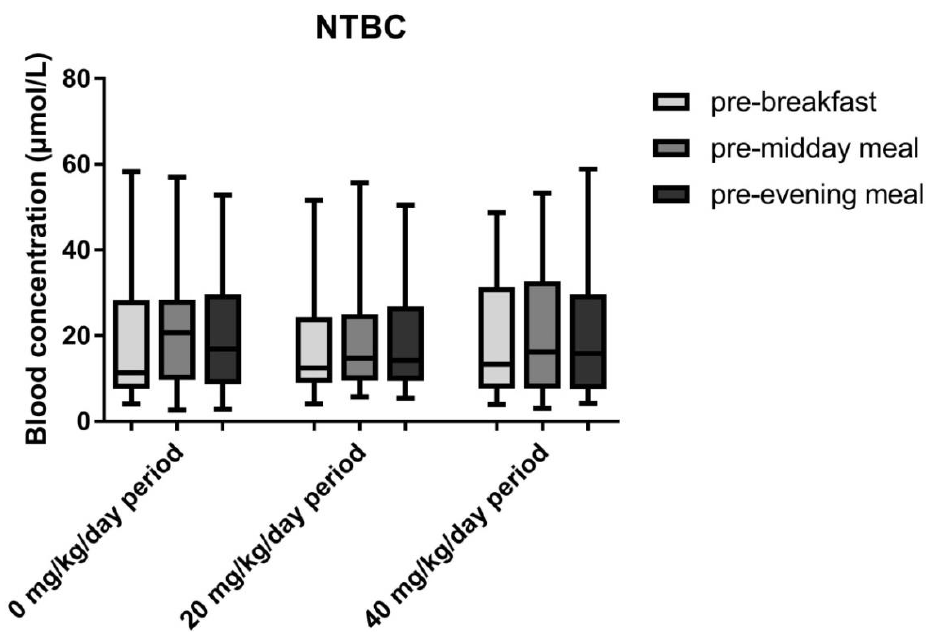
Figure 3. Mean blood NTBC concentrations during the di ff erent study periods presented as min–max whiskers. Blood NTBC concentrations showed diurnal variation during all study periods ( p = 0.021), with lowest concentrations pre-breakfast and highest concentrations pre-midday meal. No di ff erences in blood NTBC concentrations between the study periods (0, 20 and 40 mg / kg / day phenylalanine) were found.